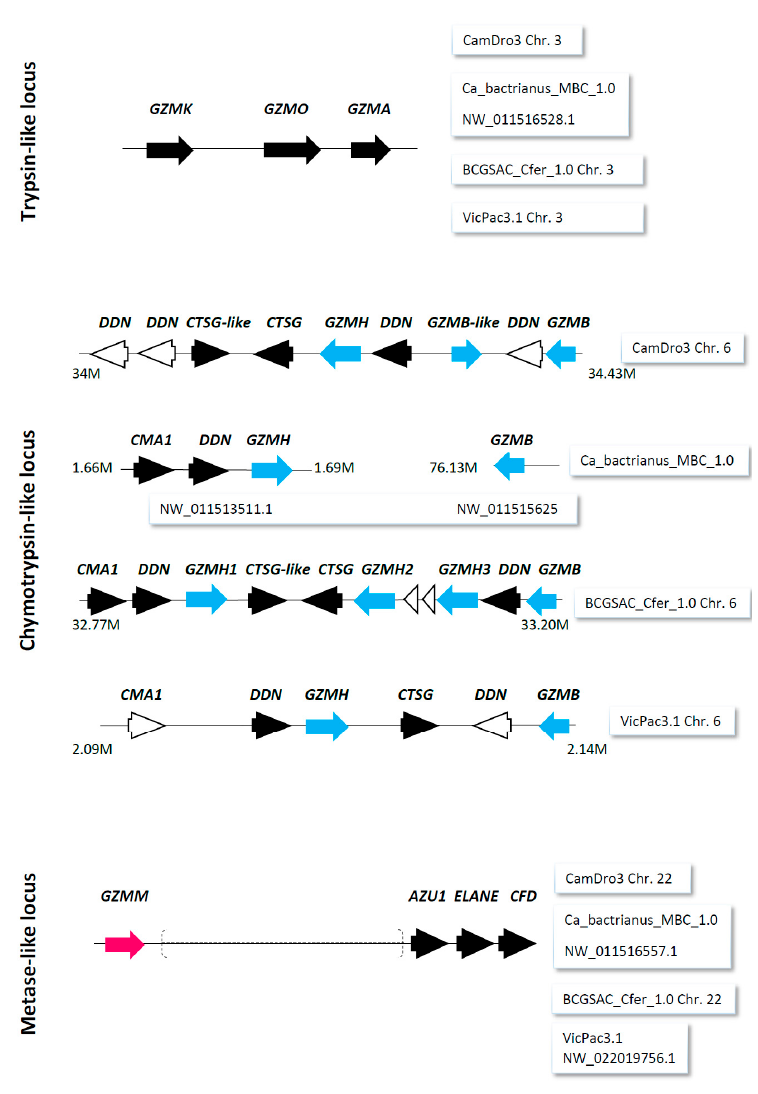
Figure 1. Genomic organization of granzyme genes in camelids. Three separate genomic regions (trypsin-like, chymotrypsin-like, and metase-like locus) contain granzyme coding genes ( GZMA , GZMB , GZMH , GZMK , GZMM , and GZMO ) in NCBI reference genomes of camels and alpaca (see tags). Other closely related potentially functional genes (full arrows) or pseudogenes (empty arrows) were duodenase ( DDN ), cathepsin G ( CTSG ), chymase ( CMA1 ), azurocidin ( AZU1 ), neutrophil elastase ( ELANE ), and complement factor D ( CFD ). The presence of non-homologous genes in the metase-like locus is indicated by parentheses. Coordinates are given in megabases (M). cyan, magenta—highlight granzyme